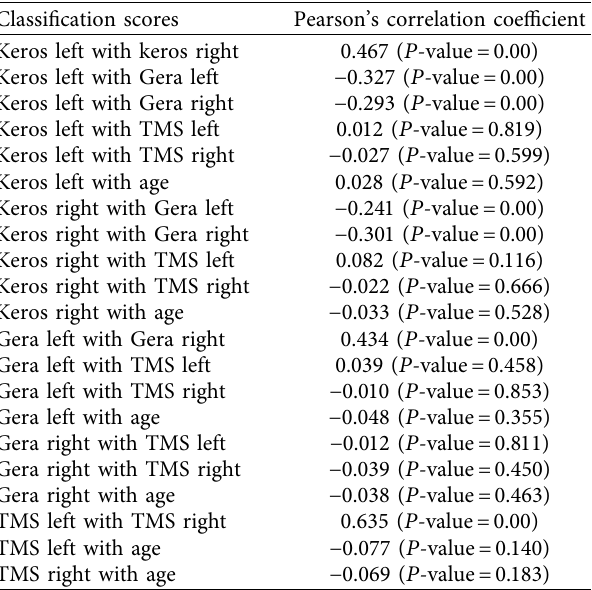
Table 6: Pearson’s correlation coefficient between